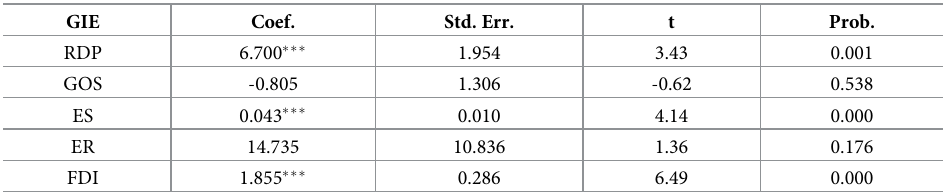
Table 7. Panel Tobit regression results in 16 heavily polluted industries.